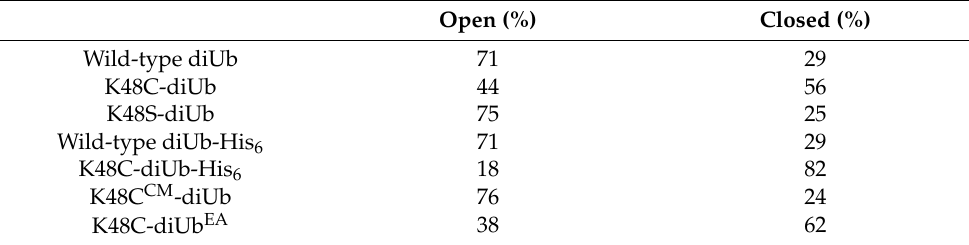
Table 1. The populations of open and closed forms at 25 ◦ C, pH 7.0.